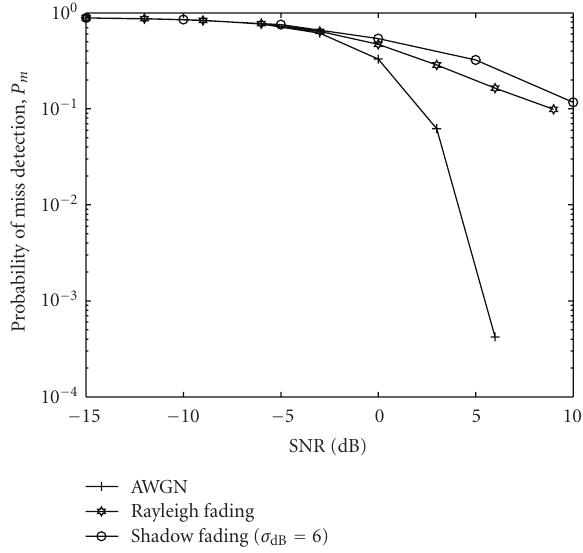
Figure 3: Probability of miss detection versus minimum detected SNR in shadow fading for P f = 10 − 1 , γ dB = 5, N =